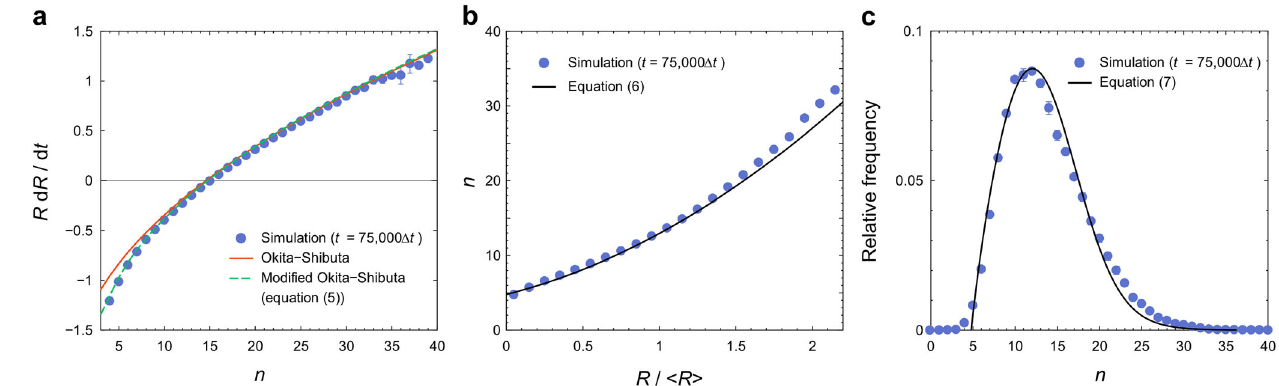
Fig. 4 Comparison of theoretical models and simulated results for the grain-topology-related aspects of steady-state ideal grain growth. a Average growth rate for each topological class. b Average topological class for each size class. c Grain topology distribution. In all panels, numeric data points are given as the average of three replicated simulations for 2560 3 -point systems, with error bars representing the standard deviation. For most of the data points, the error bars are smaller than the